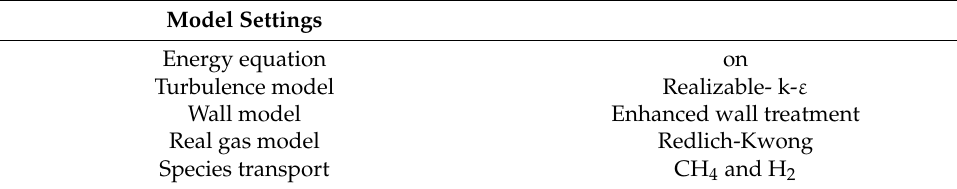
Table 3. Model settings.